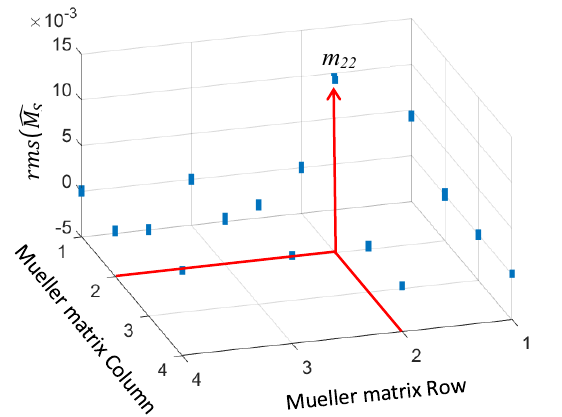
Fig. 4. Individual values of the differences of the 4 × 4 elements between Mueller matrix obtained for each realization of the simulation and the theoretical one. The case of air for 500 realizations of the simulation with a standard deviation of the added Gaussian noise (cid:2) =0.02 is